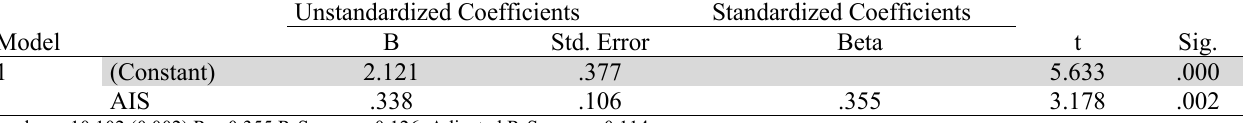
The summary of regression analysis on the effect of AIS on performance evaluation within corporate governance outcomes Model